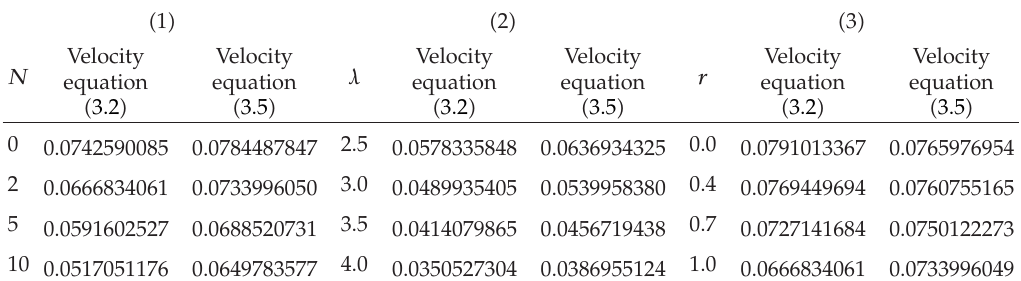
Table 1: Comparison of velocity solution (cid:5) 3.6 (cid:6) at the centre of the channel due to (cid:5) 3.2 (cid:6) and (cid:5) 3.5 (cid:6) ,